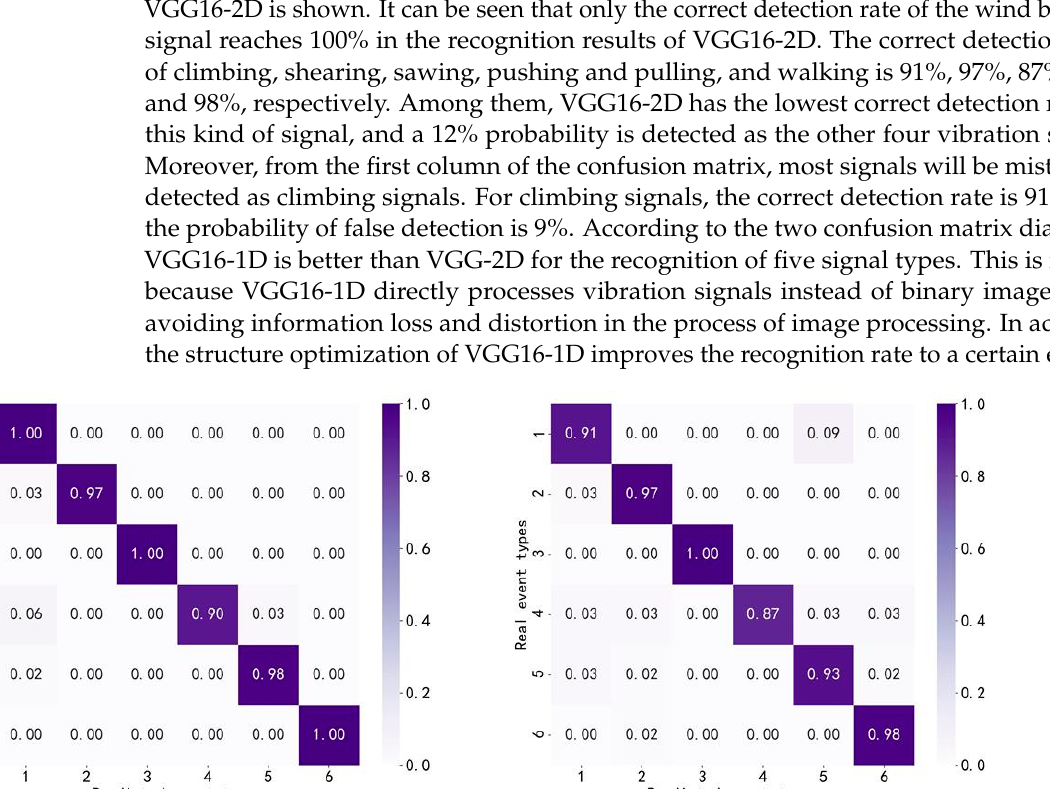
Table 2. Model identification results.